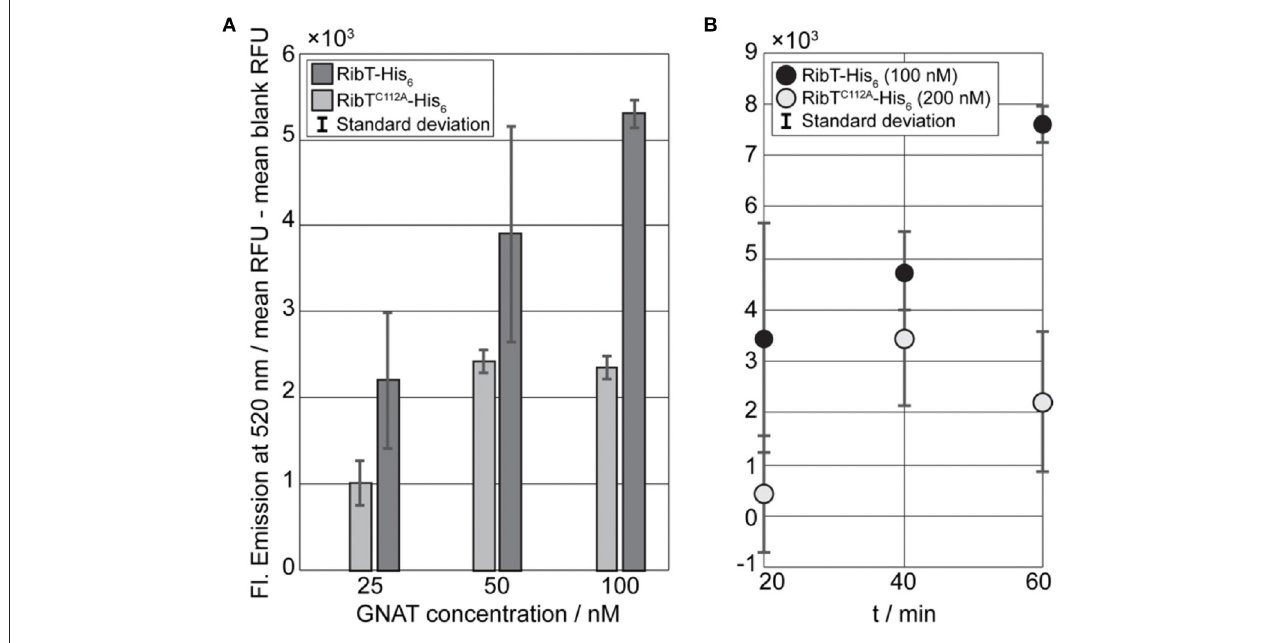
FIGURE 4 | Fluorescence-based GNAT assays for the detection of RibT activity toward RibH. (A) Results of the GNAT titration end point assay using RibT-His 6 and mutant RibT C112A -His 6 in concentrations of 25nM, 50nM, and 100nM, with a constant concentration of acceptor substrate Strep-RibH at 10 µ M. Reactions were initiated by the addition of the GNAT enzyme to acceptor substrate and allowed to proceed at room temperature for 30min until reactions were quenched, and resulting fluorescence was measured at 520nm. All the samples prepared in duplicate standard deviation are shown within the bars. Prior to plotting, blank values were subtracted from measured sample values. (B) Kinetic GNAT end point assay using RibT-His 6 (100nM) and mutant RibT C112A -His 6 (200nM) with a fixed acceptor substrate concentration of 10- µ M Strep-RibH. The reactions were initiated by the addition of the GNAT enzyme to acceptor substrate and allowed to proceed at room temperature for different time intervals, resulting fluorescence was measured at 520nm. Prior to plotting, blank values had been subtracted from measured sample